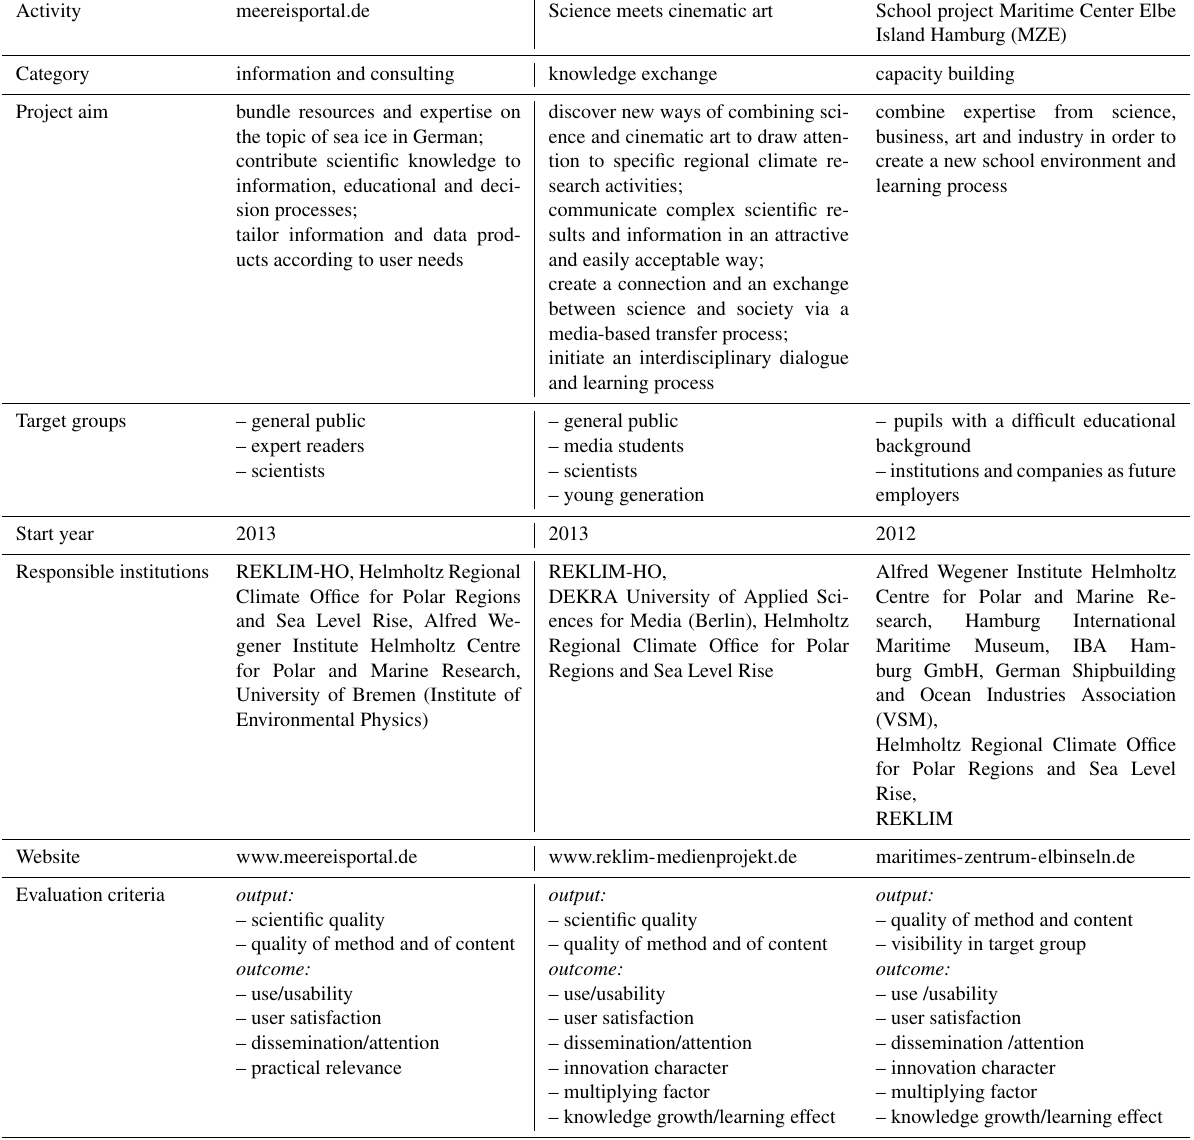
Table 2. Overview on the case examples in the field of knowledge transfer and dialogue processes.